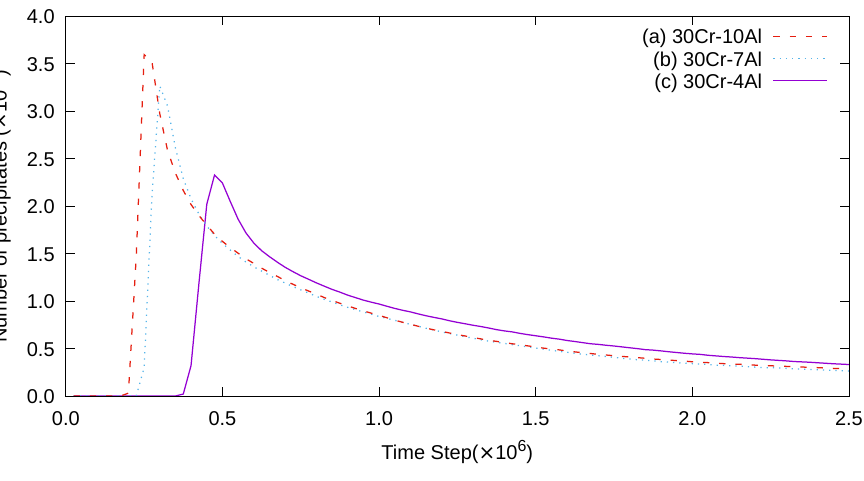
Figure 13. Number of α (cid:48) precipitates of the 3D simulation at an average Cr concentration of 30% when the average Al concentration was ( a ) 10%, ( b ) 7%, and ( c ) 4%. Overshooting was observed before the t ∗ = 1.0 × 10 6 in ( a – c